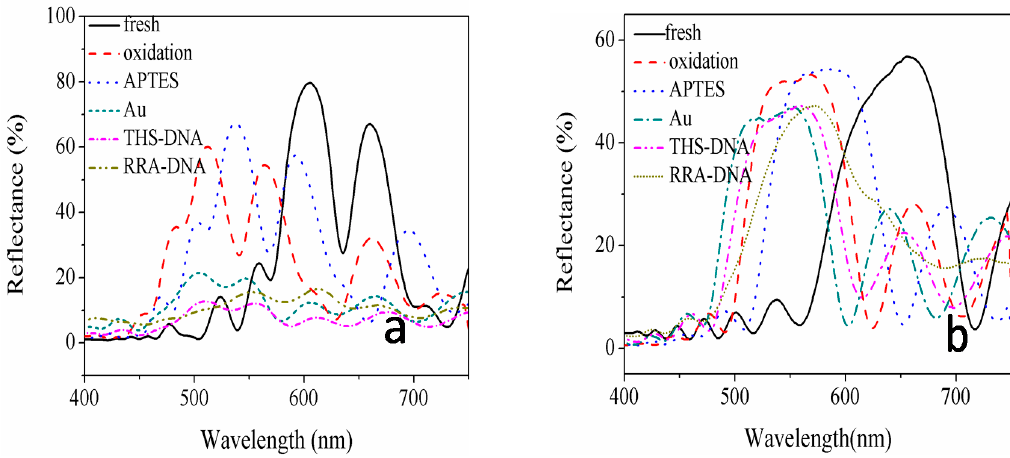
reflector Figure 7. The reflection spectra vary with the preparation process of ( a ) PSiMC biosensor, and ( b ) Bragg reflector sensor.